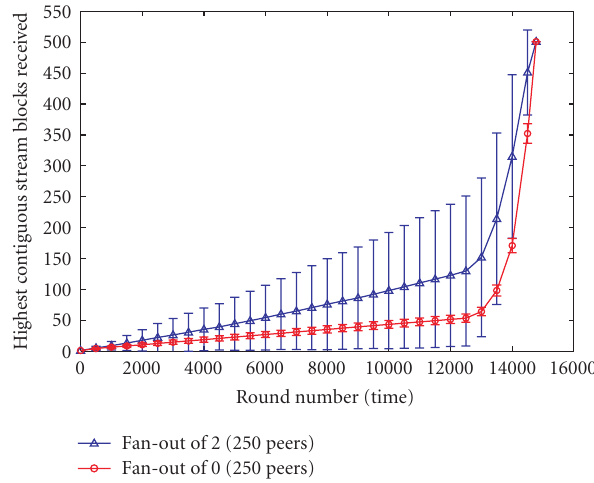
Figure 3: Optimistic unchoke fraction δ i = 0 . 01 for all i , 500 peers, 500 stream blocks. A constant streaming rate to peers is supported; and the peer-wise proportional fairness incentive algorithm di ff er- entiates peers according to their bandwidth contributions to the P2P network.